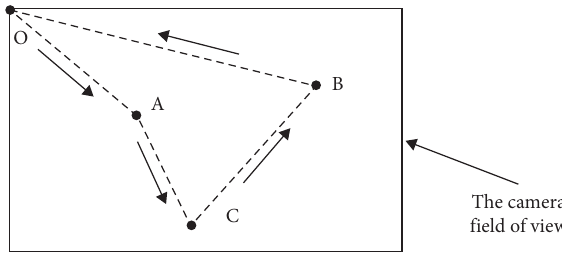
Figure 9: Detection path.